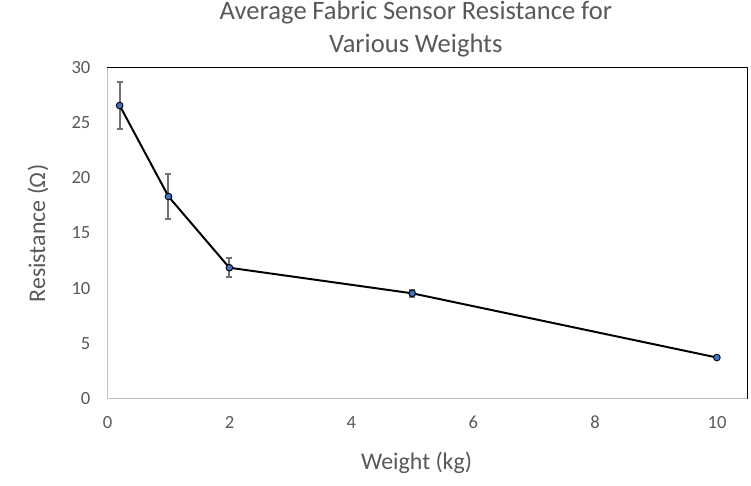
Figure 7. Average measured resistance for fabric sensors under various